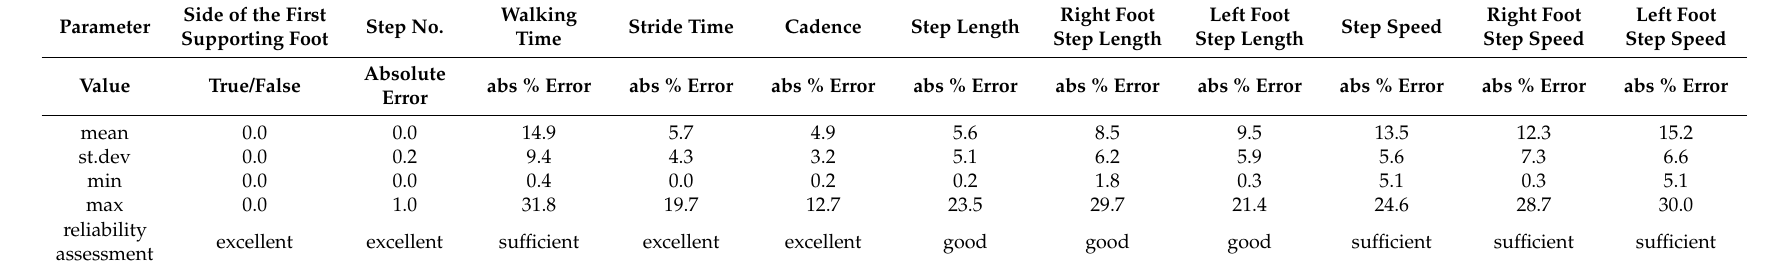
Table 4. Novel system validation: comparison between gold standard GA results and wearable system absolute error